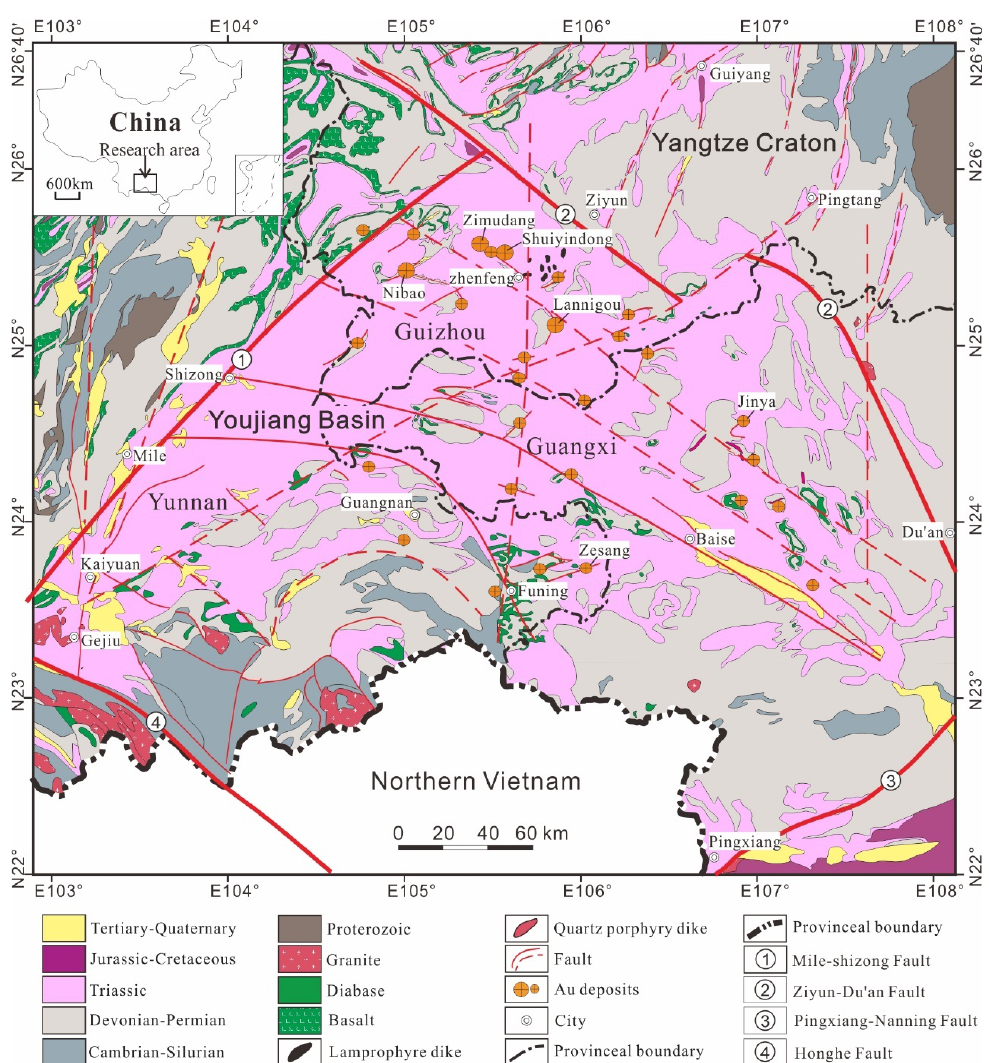
Figure 1. Geologic map of the Dian-Qian-Gui “Golden Triangle” region in Southwestern China (modified after Su et al. [5] and 1:2,500,000 Chinese geological map [6] ).